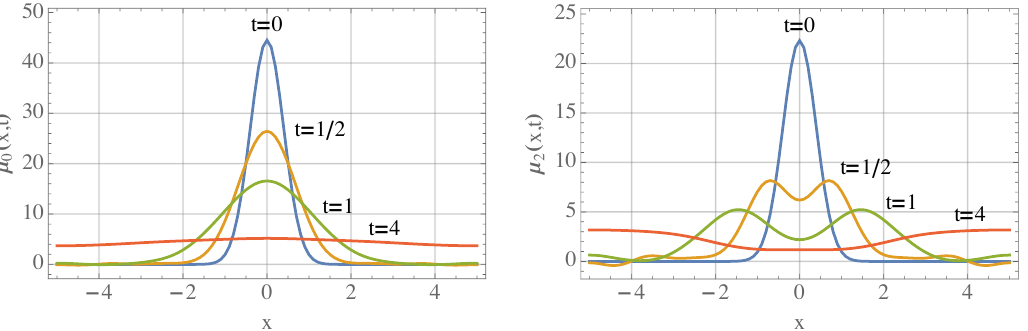
Figure 9: Dynamics of the initial Gaussian perturbation (34) over a thermal back- ground with c = 1 and β = 1. Left panel: space-time dependence of the 0th moment µ ( t , x ) of the δ n ( θ , t , x ) distribution. Right panel: plot of the 2nd second moment 0 µ ( t , x ) 2